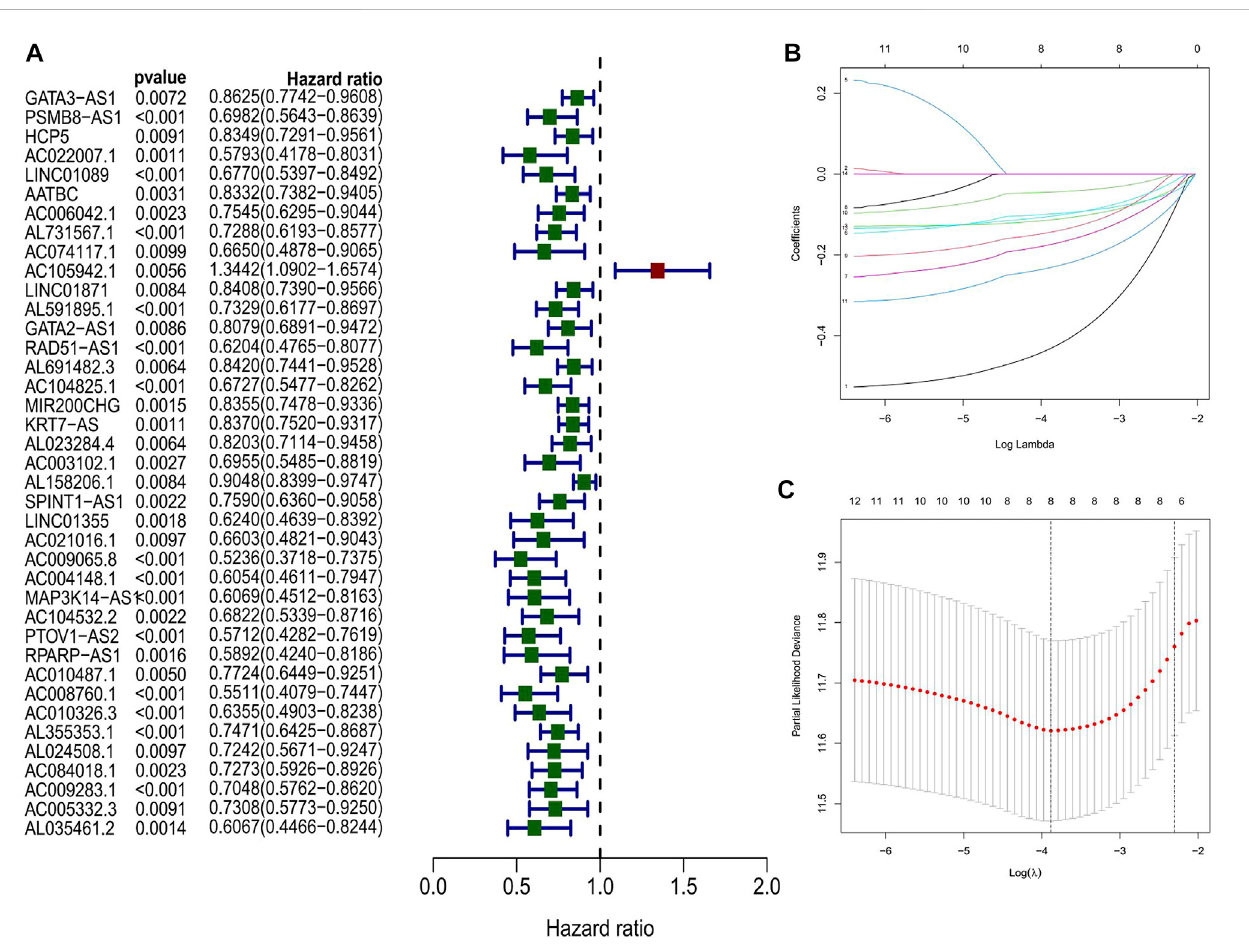
FIGURE 2 (A) Identi fi cation of prognostic PRR by univariate Cox regression analysis in the whole group (B, C) Lasso regression analysis in the entire